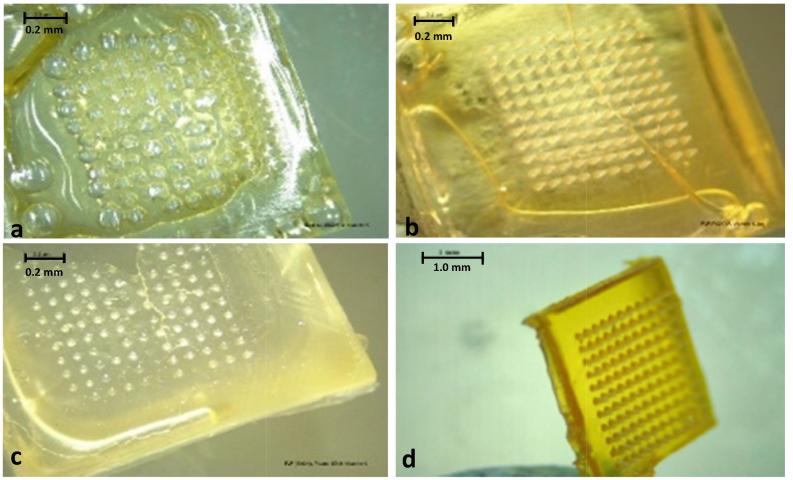
Light microscope images of vitamin K MN formulations. a) MN formulated from 20% w/w Gantrez® S-97 in 100% ethanol produced a large number of bubbles throughout the array. b) MN formulated from 20% w/w PVP in 100% ethanol produced a brittle needle, although all the needles did form. c) MN formulated from 20% w/w PVP in deionised water, containing 5% w/w Tween 80® produced a very brittle needle. Some needles did not form either. d) MN formulated from 20% w/w Gantrez® S-97 and 5% w/w Tween® 80 created a strong array with fully formed needles.